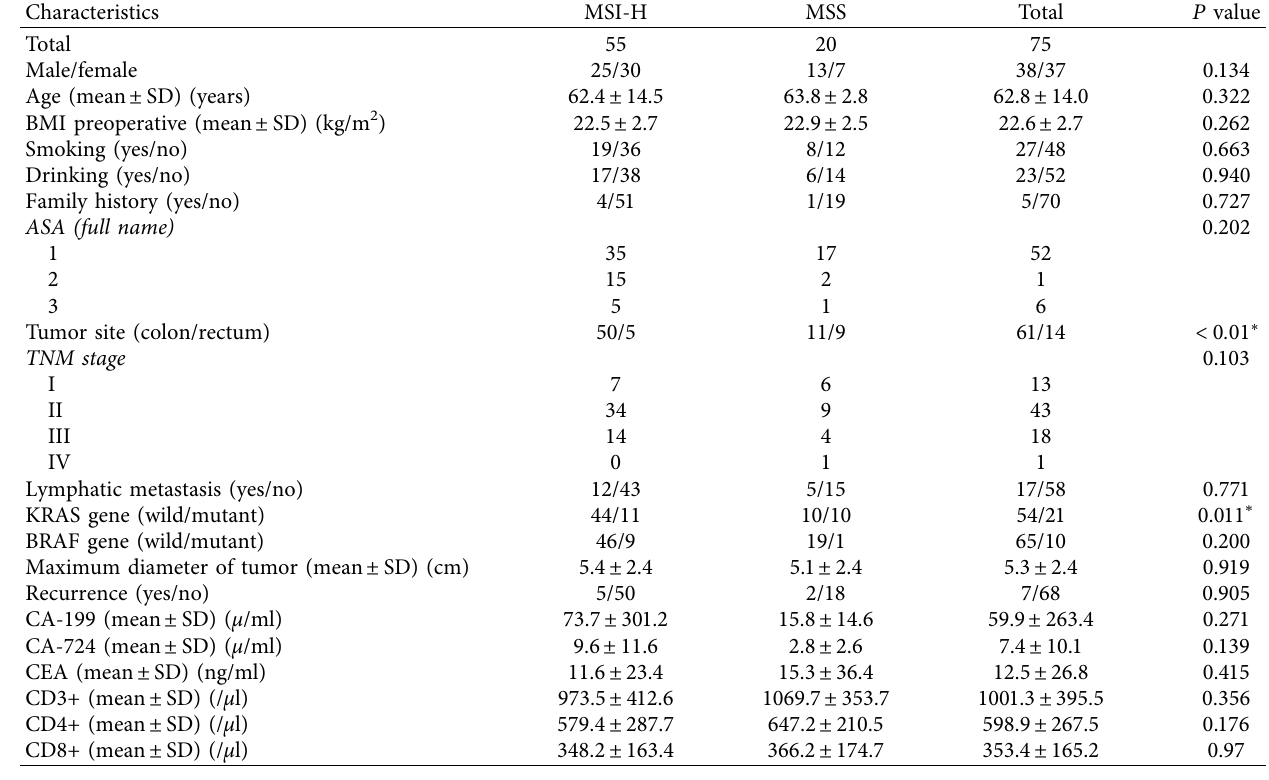
Table 2: Correlations between clinic features and MSI status in DMMR CRC patients.